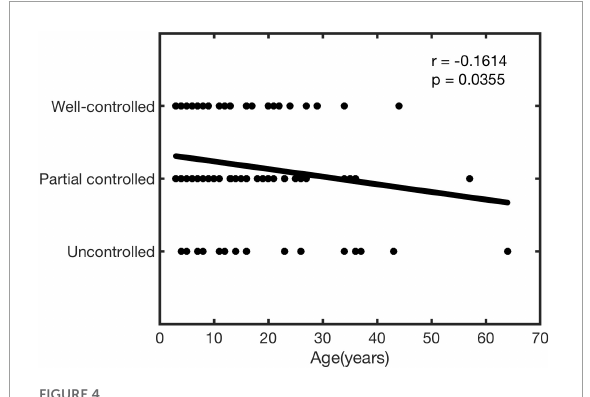
FIGURE4 Analysis of correlation between age and clinical